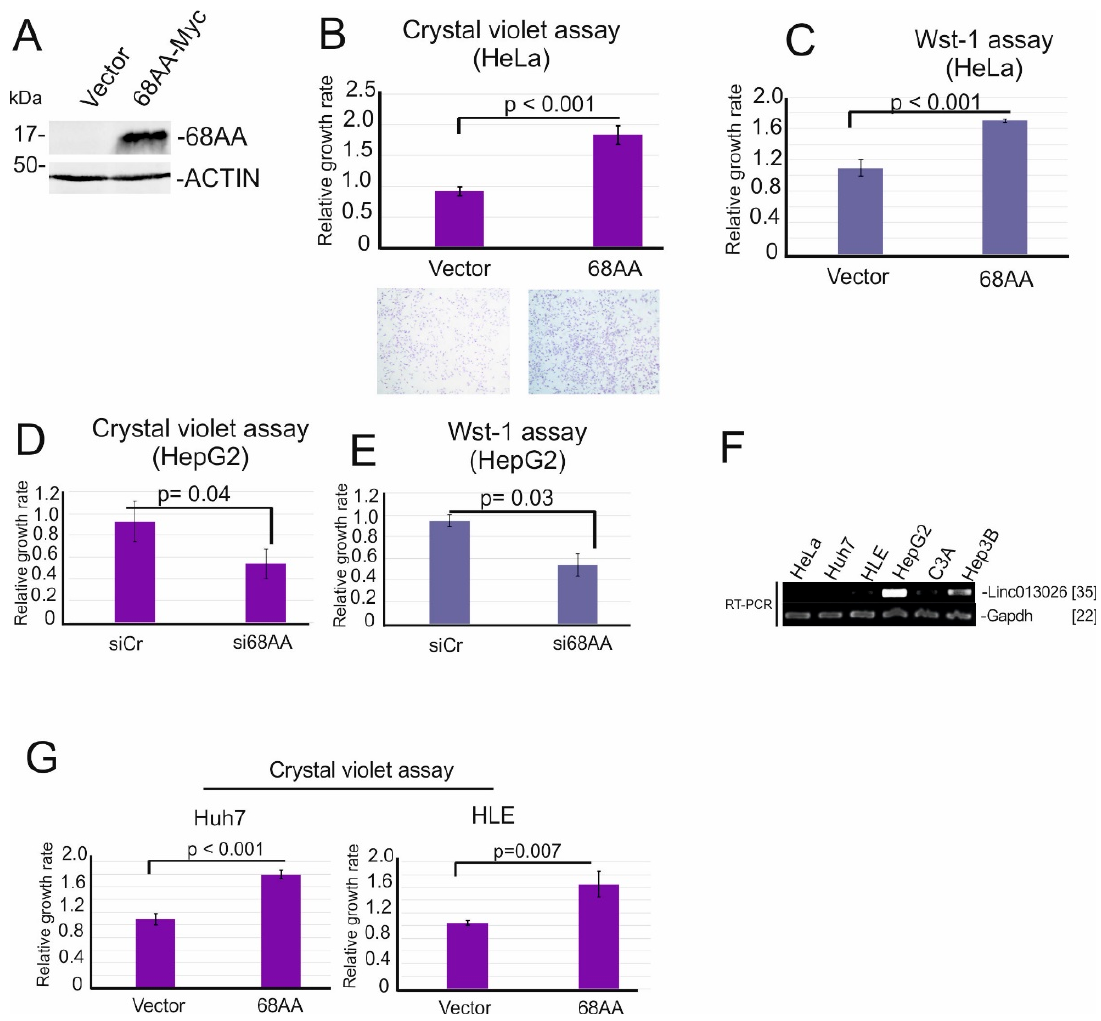
Figure 4. Linc013026-68AA enhances cell proliferation. ( A ) HeLa cells were transfected with Myc- tagged Linc013026-68AA (68AA-Myc) and pcDNA3.1 MycHis (Vector) vector for two days and anti-Linc013026-68AA- and Actin-specific immunoblot were performed. ACTIN was used as loading control. ( B , C ) Sister cultures of ( A ) were supplied for crystal violet- ( B ) and Wst-1 assay ( C ) to examine the effect of Linc013026-68AA on cell proliferation. ( D , E ) HepG2 cells were transfected with siRNA control (siCr) and siLinc013026 (si68AA) for three days and supplied for crystal violet- ( D ) and Wst-1 assay ( E ). ( F ) Total RNAs were isolated from HeLa, Huh7, HLE, HepG2, C3A and Hep3B cells. The expression of Linc013026 was examined using RT-PCR. Gapdh mRNA was used as loading control. [] indicates number of PCR cycles. ( G ) Huh7- and HepG2 cells were transfected with Myc-tagged Linc013026-68AA (68AA-Myc) and pcDNA3.1 MycHis (Vector) vector for two days and supplied for crystal violet- and Wst-1 assay. Three independent experiments were performed for crystal violet- and Wst-1 assay. Numbers are mean ± standard deviation (SD). p: p